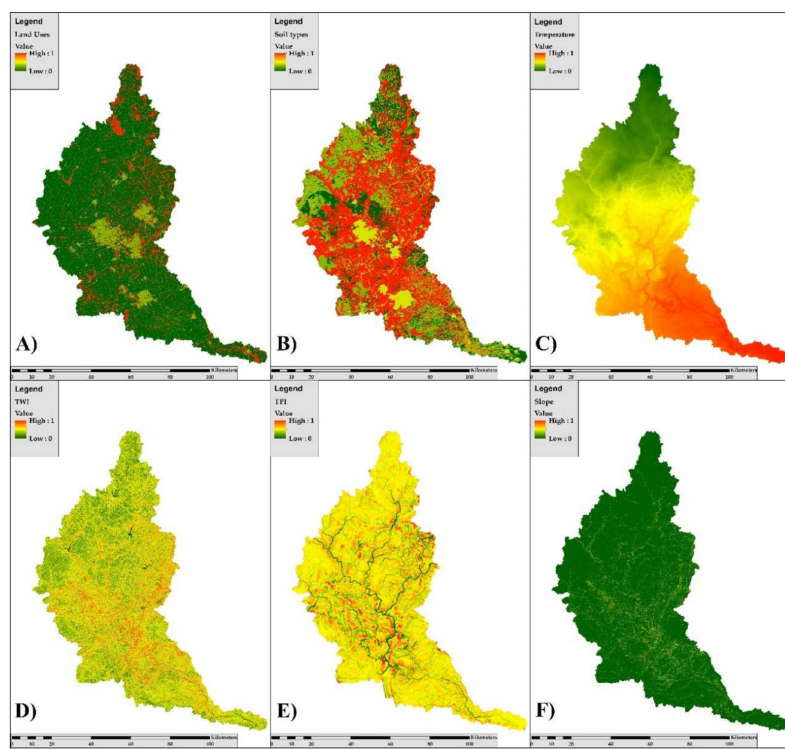
Figure 2. Normalized spatial distributions of the selected criteria. Low refers to less e ff ective and high to more e ff ective filtering potential, based on each criterion’s features. The selected criteria. ( A ) Land use; ( B ) Soil type; ( C ) Temperature; ( D ) Topographic wetness index (TWI); ( E ) Topographic position index (TPI); ( F )